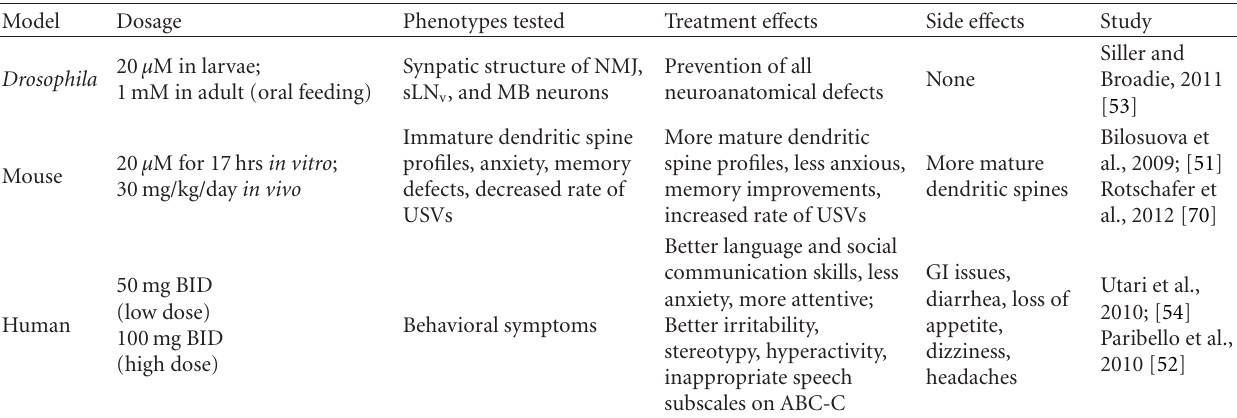
Table 1: Summary of recent minocycline treatment trials in Drosophila and mouse disease models, and human clinical studies. The columns display the systems, minocycline dosages, phenotypes tested, treatment outcomes and side e ff